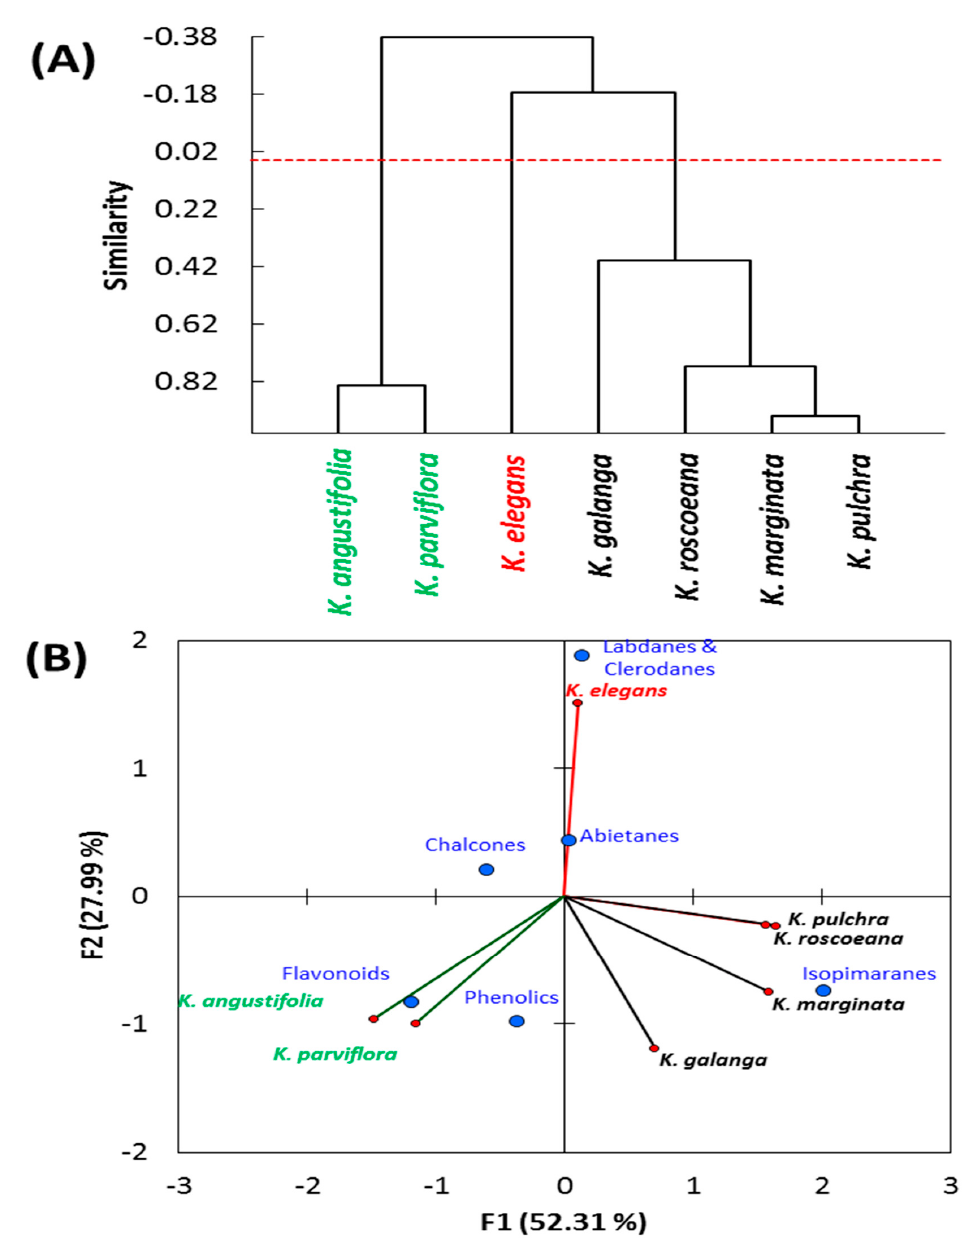
Figure 3. ( A ) Agglomerative hierarchical clustering (AHC) and ( B ) Principal component analysis (PCA) based on the chemical composition of different chemical classes of seven Kaempferia species ( K. angustifolia , K. elegans , K. galanga , K. marginata , K. parviflora , K. pulchra , and K. roscoeana ).